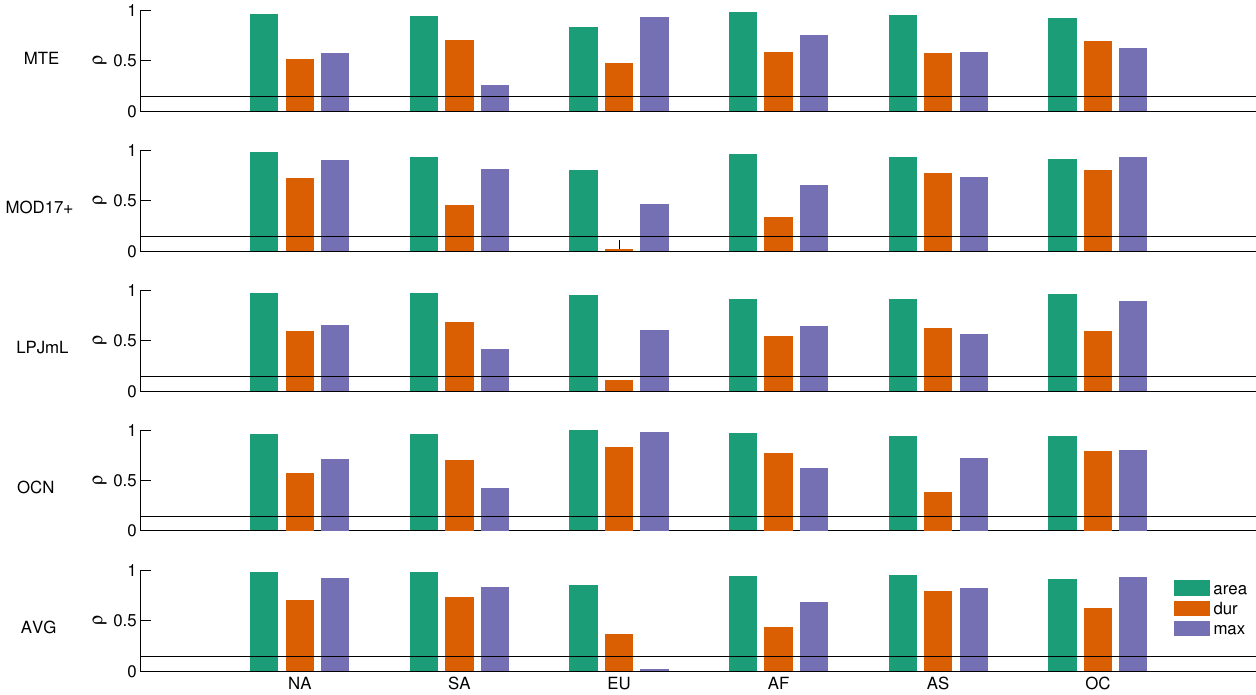
Figure 4. Correlations of spatial extent (green), duration (orange) and maximal anomaly (purple) of GPP extreme events with their overall impacts. Depicted are the correlations of extremes on all continents and the data sets MTE, MOD17+, LPJmL, OCN and AVG.